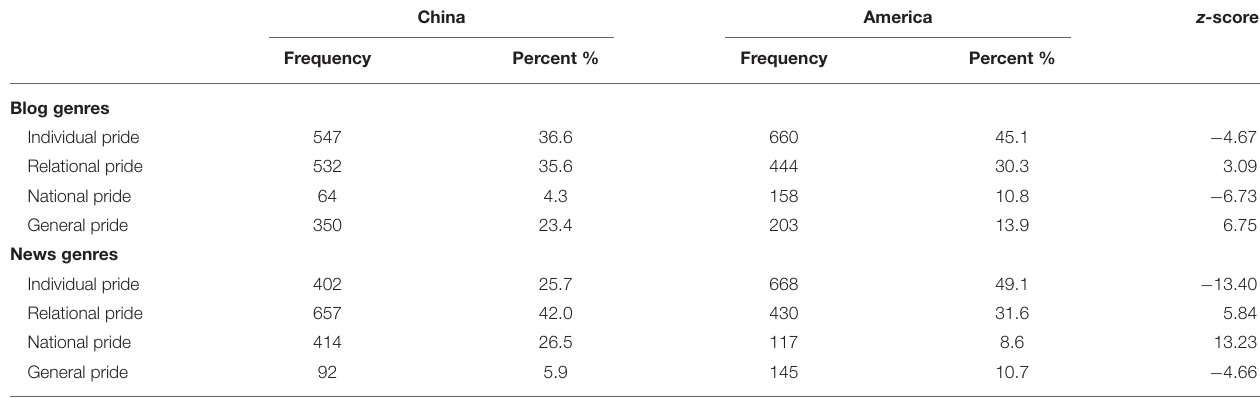
TABLE 2 | Individual pride and collective pride in Chinese and American